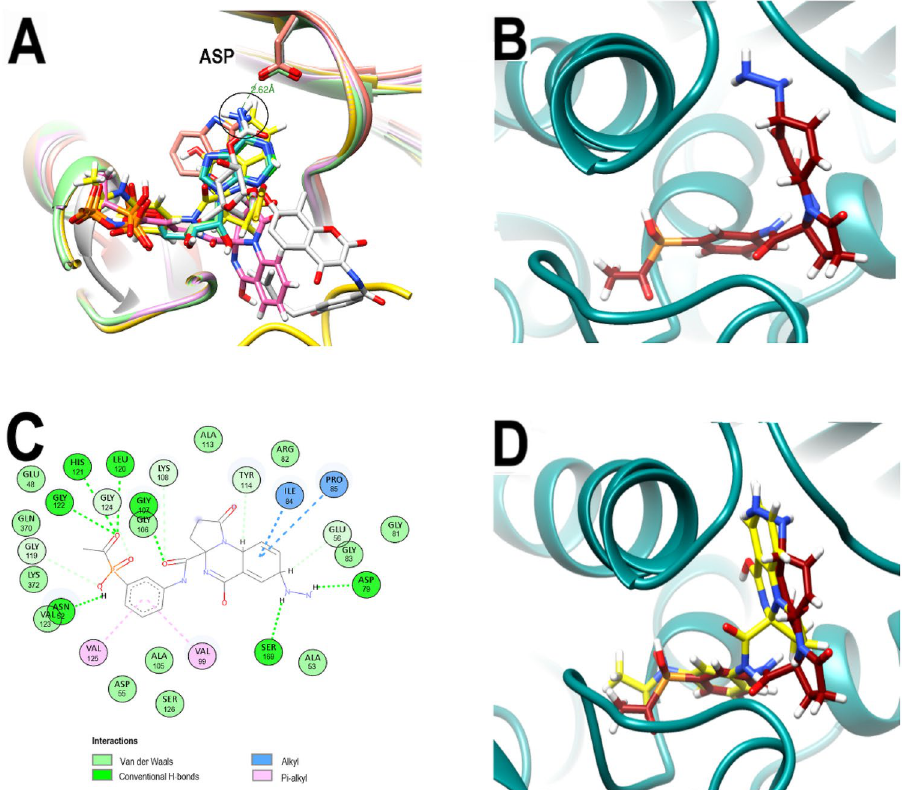
Figure 4. Comparative poses of co-crystallized ligands of diverse GyrBs and analysis of the best-predicted docking pose of PQPNN. ( A ) Computationally performed overlay of PQd and co-crystallized ligand-with GyrBs: ADP (cyan), ATP (light green) AX7 (orange), novobiocin (white), ANP (green), PQd (yellow) and PQP (magenta). The black circle highlights the overlapping nitrogen of the co-crystallized ligands. ( B ) 3D representation of the 3ZKBL-PQPNN complex. ( C ) 2D interaction diagram of the 3ZKBL-PQPNN complex. ( D ) 3D representation of PQPNN-3ZKBL complex superimposed with PQd (yellow backbone).